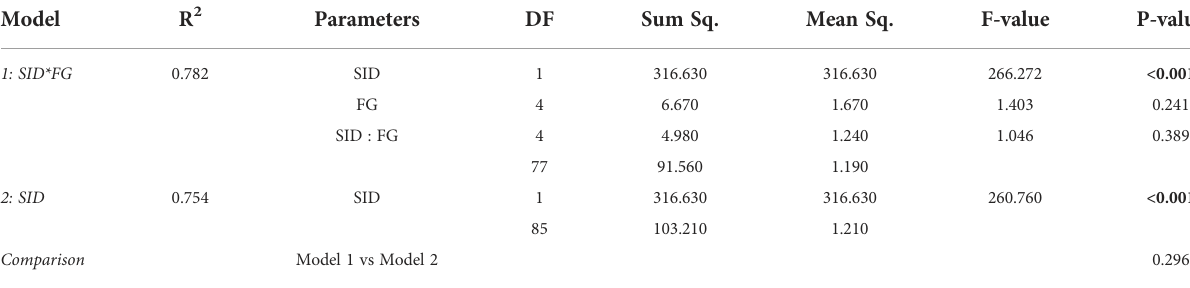
TABLE 2 Model diagnostics for regression models conducted on logit-transformed summer data. Model